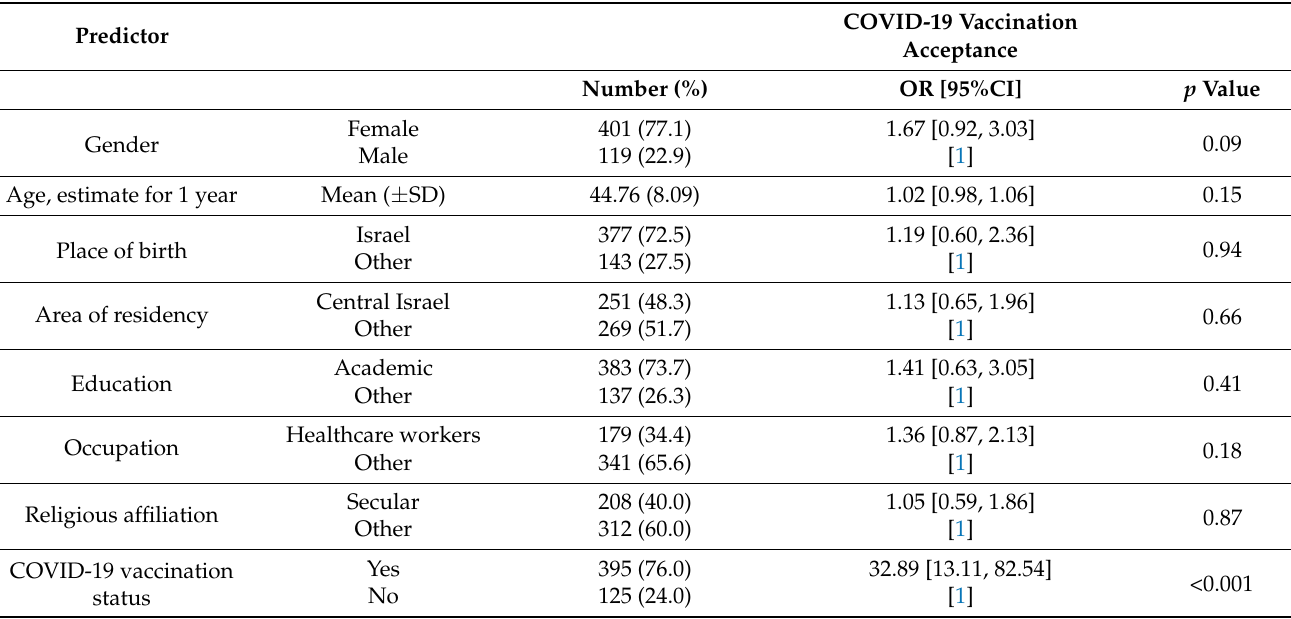
Table 1. Socio-demographic characteristics and crude odds ratios predicting COVID-19 vaccine acceptance among parents to children aged 12–15 ( N = 520).